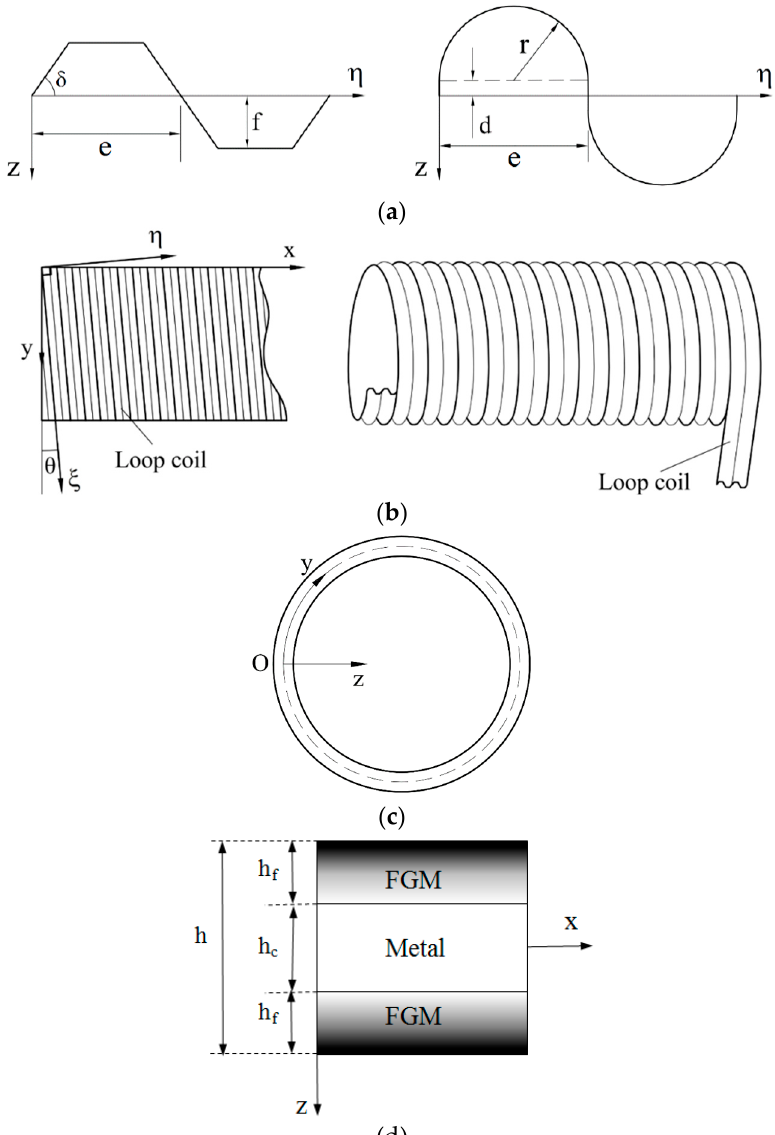
Figure 1. Configurations, local and global coordinate systems, and the material distribution of sandwich functionally graded material (FGM) cylindrical shells and corrugations. ( a ) Cross section of trapezoidal and round corrugations; ( b ) local coordinate systems; ( c ) global coordinate systems; ( d ) distribution law of sandwich FGM.